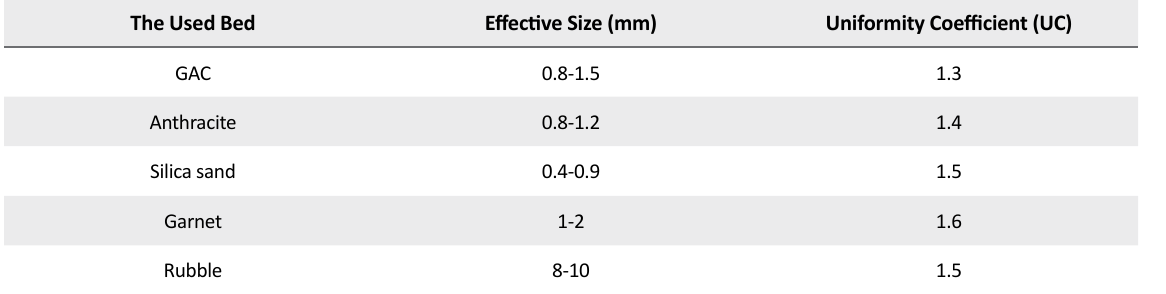
Table 2. Effective size and coefficient of uniformity of materials used in each pilot media The Used